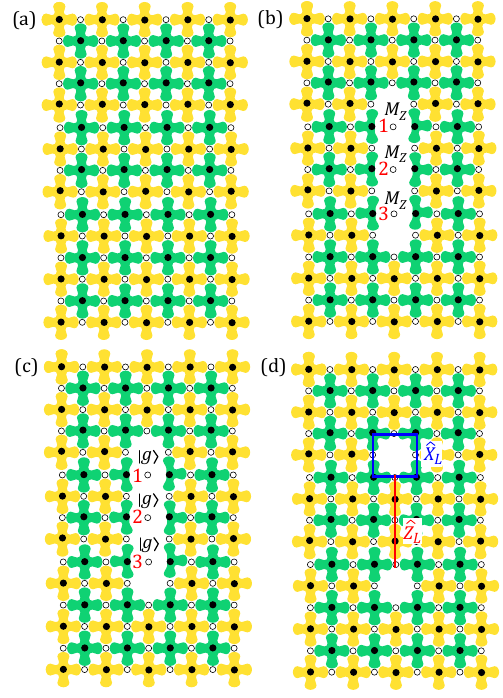
Figure 31: A “difficult” Z eigenstate initialization of an X-cut logical qubit. (a) Starting with a fully stabilized array, (b) turn off a column of four measure-X qubits, switch the adjacent measure-Z qubits from 4- to 3-terminal measurements, and perform Z measurements of the data qubits numbered 1, 2 and 3, to maintain error tracking. (c) Reset the data qubits 1, 2 and 3 to | g 〉 , and (d) turn two of the measure-X qubits back on, switch the adjacent measure-Z qubits back to 4-terminal measurements, resulting in a logical qubit initialized in | g step (c). Figure from Ref. (Fowler, Mariantoni, Martinis and Cleland,